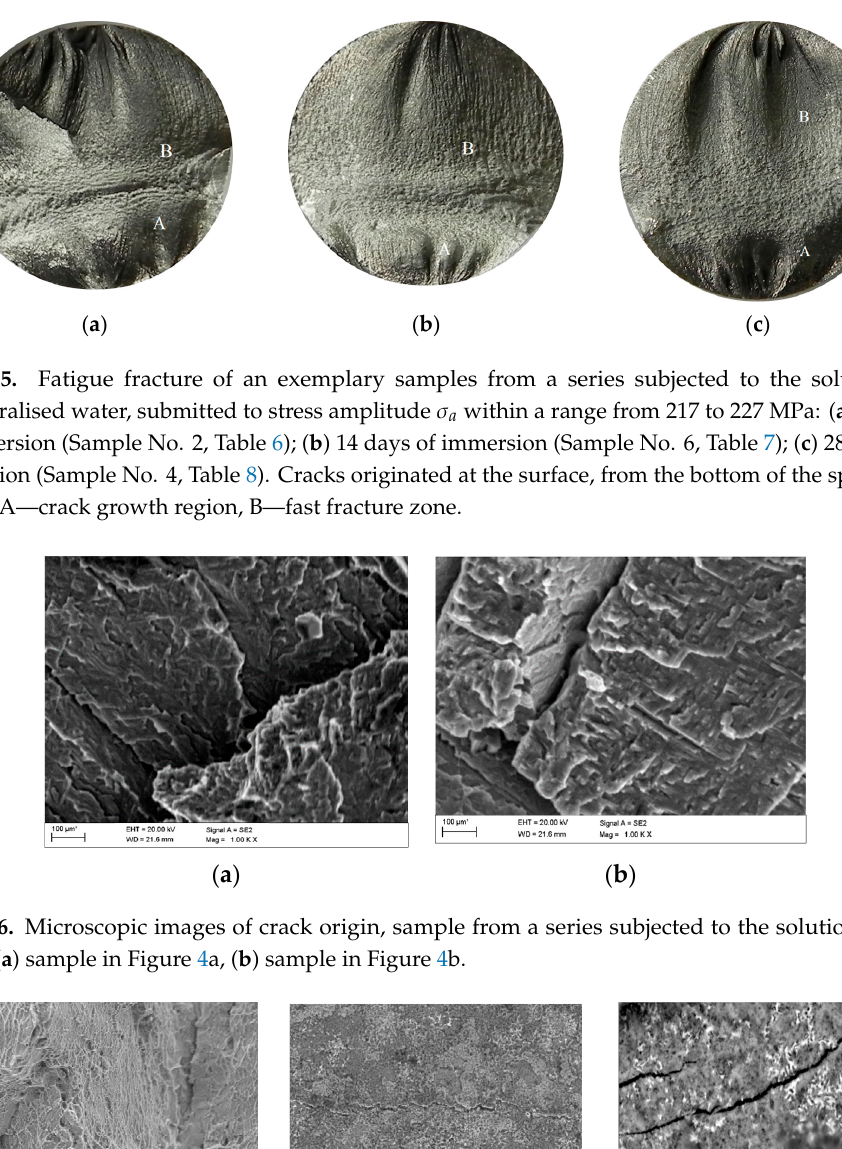
Figure 4. Fatigue fracture of exemplary samples from a series subjected to the solution in tap water, submitted to stress amplitude σ a = 162 MPa: ( a ) 7 days of immersion (Sample No. 3, Table 4); ( b ) 14 days of immersion (Sample No. 15, Table 5). Cracks originated from the bottom of the specimen, where: A — crack growth region, B — fast fracture zone.